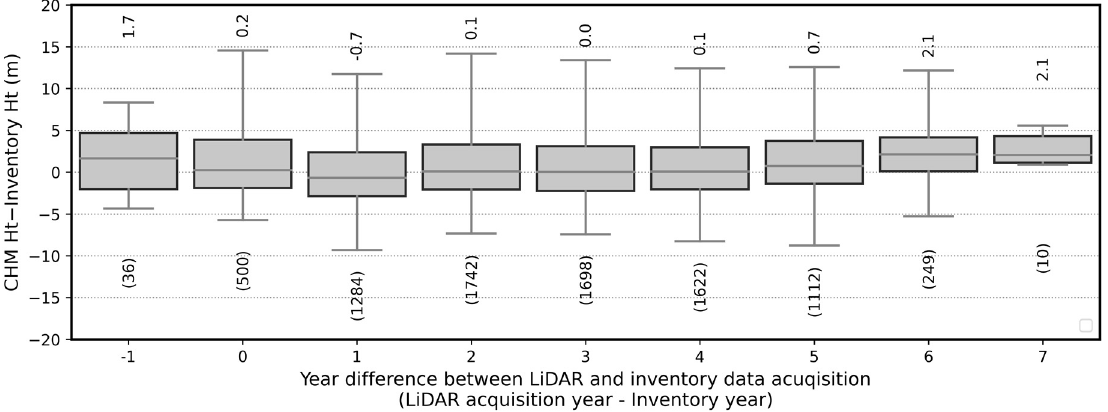
Figure 14. Height measurement error with respect to time difference between inventory and LiDAR data acquisition. Boundaries of upper and lower whisker is the ninety-seventh and third percentiles. The number above each box plot is median, and the number below box plot is number of data points. CHM: canopy height model; Ht: height.